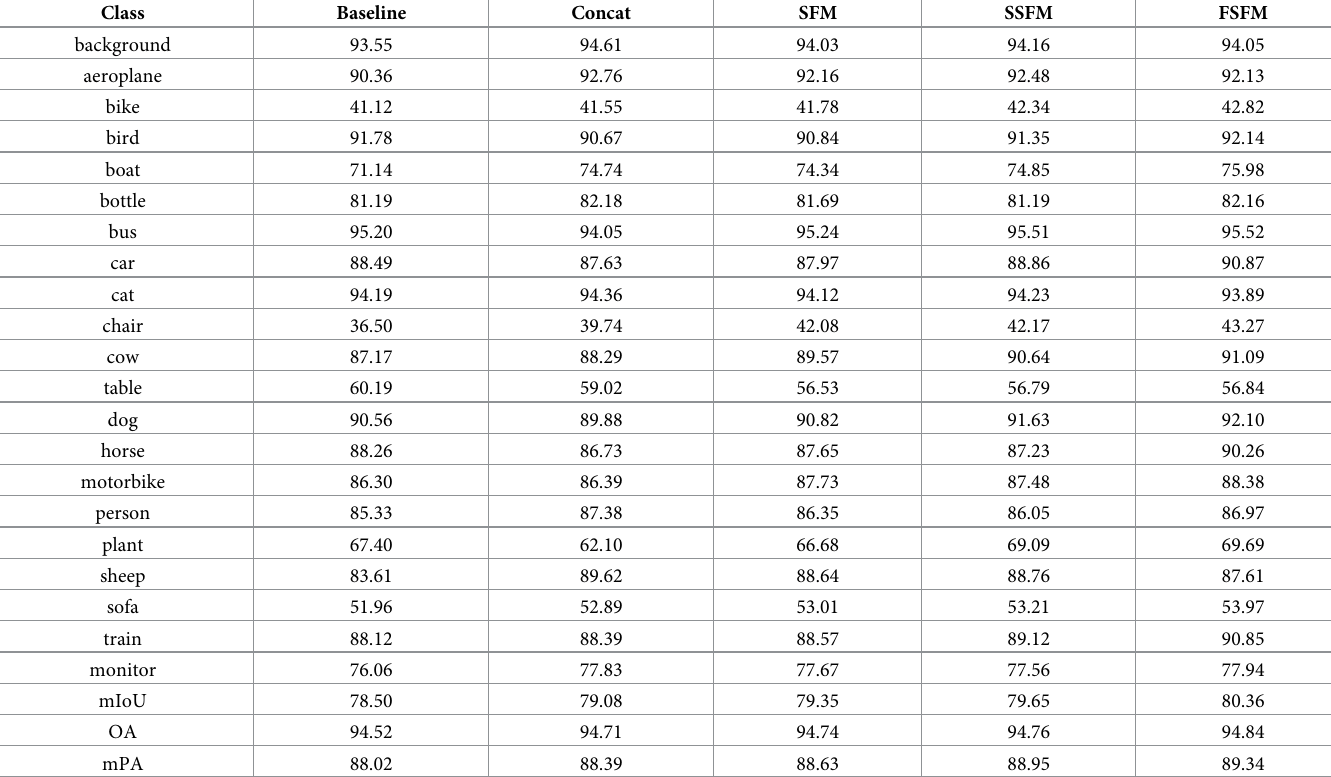
Table 3. Ablation results on the PASCAL VOC 2012 valuation set. Concat refers to the use of concatenation operations to fuse the output of DAPM. SFM: Selective Fuse Module. SSFM is the addition of the Spatial Attention Mechanism to each of the two branches of SFM. FSFM refers to the Focusing Selective Fuse